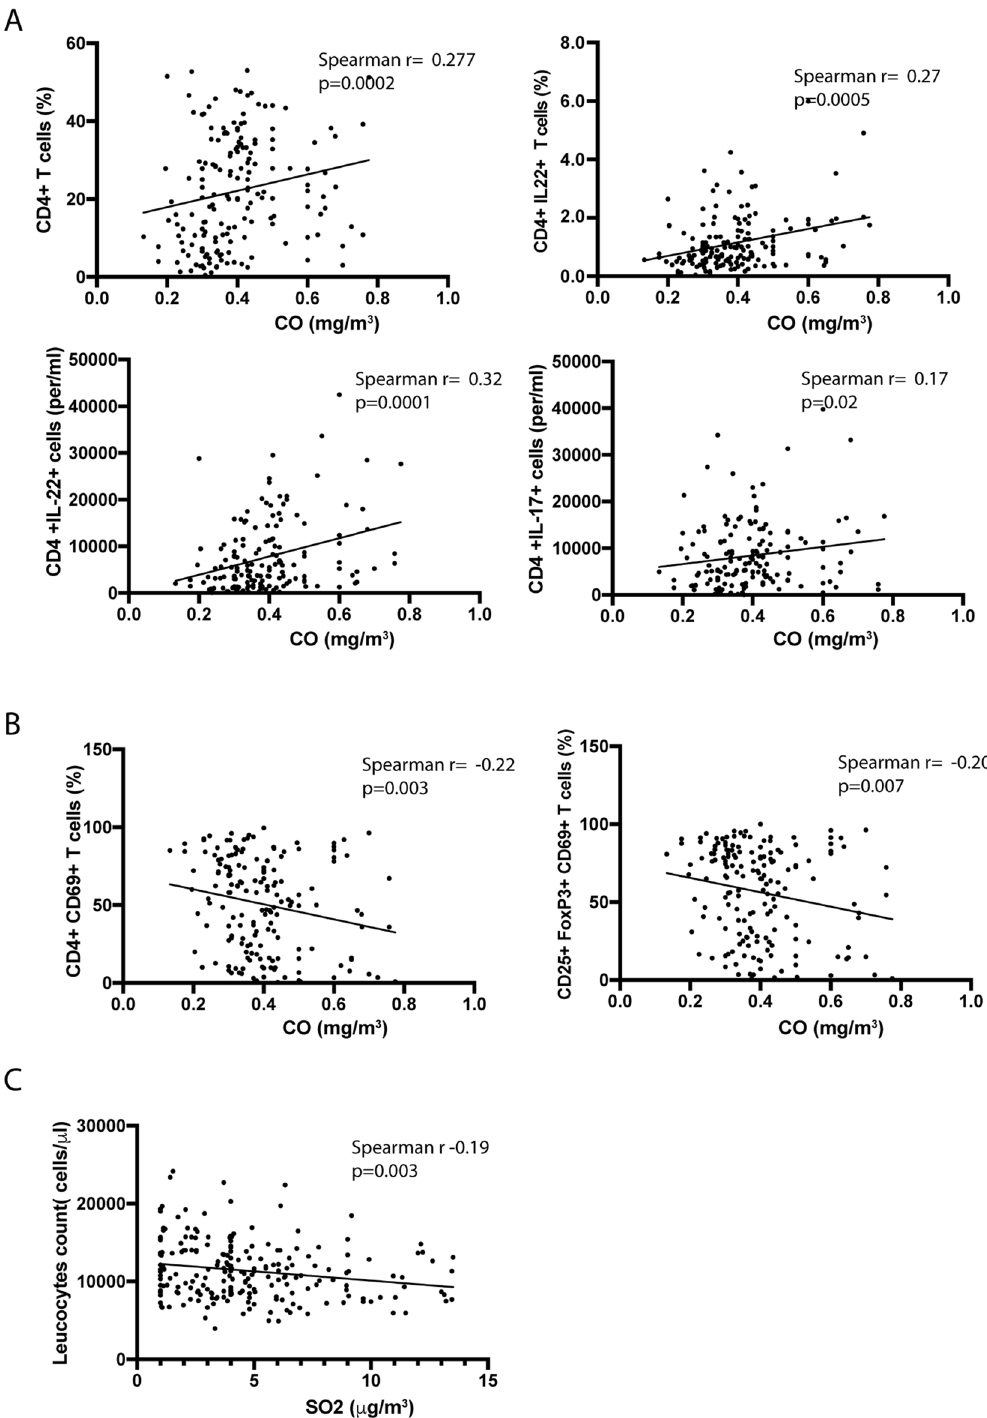
Figure 3. Correlations of CO and SO 2 exposure with circulatory immune cells. Scatter plots of significant correlations are shown. Correlation was assessed by Spearman test. ( A ) CO exposure had a positive correlation with the percentage of CD4 + T cells as well as with IL22- and IL-17-producers CD4 + T cells. ( B ) Negative correlation of CO exposure with CD4 + CD69 + lymphocytes and CD69 + Treg cells. ( C ) SO 2 exposure was associated with a decrease of total leucocytes